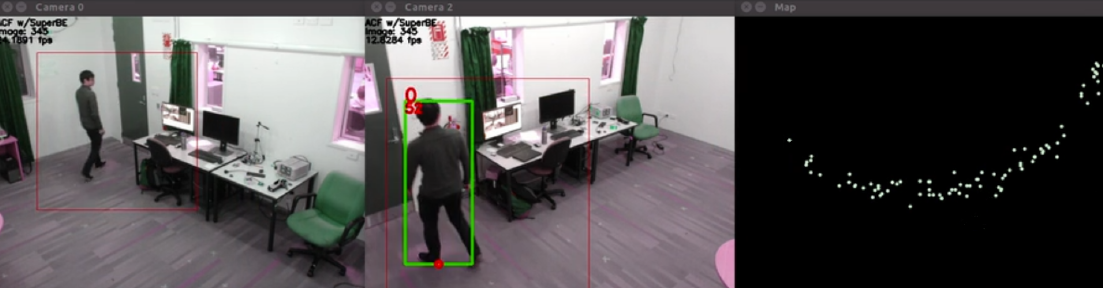
Figure 4. An example of the positions of a detected person being mapped over time. The top edge of the map corresponds to the wall with the door shown in the two camera